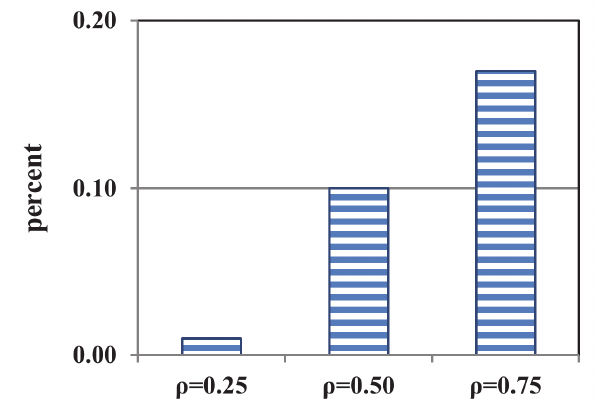
Fig. 6. The AEP of the MSTS for ρ